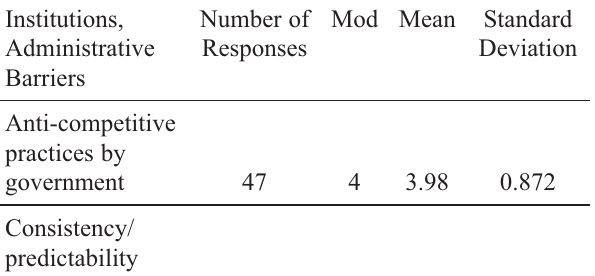
Table 7 . Barriers to Foreign Direct Investment in Turkey